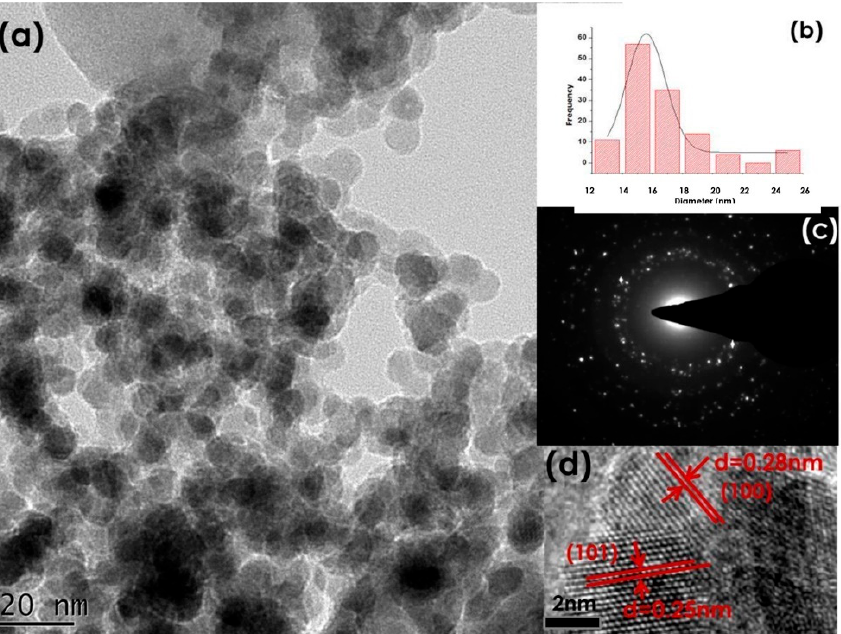
Figure 5. ( a ) TEM image of the synthesised ZnO NPs ( b ) with their size distribution ( c ), their SAED pattern and ( d ) High-Resolution Transform Electron Microscope (HRTEM) image. Adapted from [22].